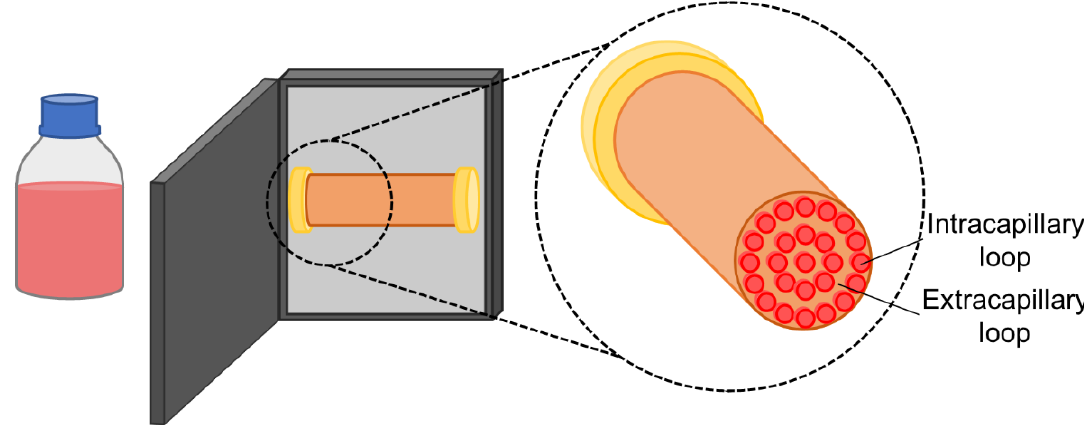
Figure 4. Schematics of a hollow fibre bioreactor system and a close-up of the hollow fibre mod-